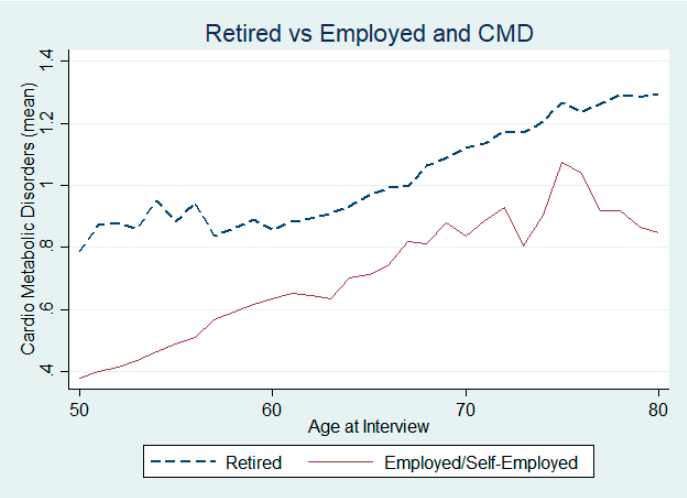
Figure 5. Chronic CMDs between employed and retired individuals.